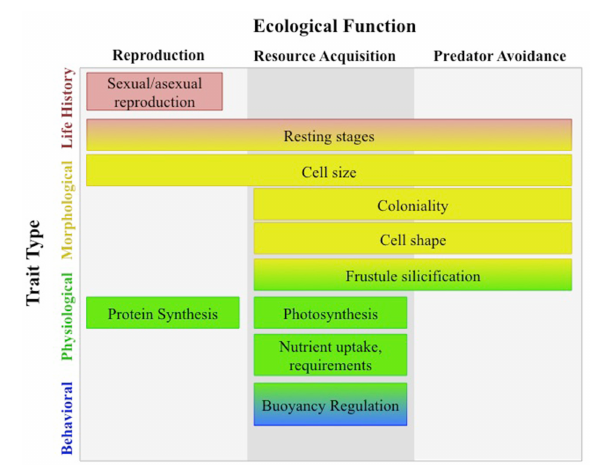
FIGURE 1 | Typology of diatom functional traits redrawn from Litchman and Klausmeier (2008). Trade-offs between many functional traits have significant implications for the functional ecology of marine systems as many of these traits are involved in resource acquisition and have direct control over biogeochemical fluxes. Physiological traits such as nutrient uptake directly affect the elemental cycles of carbon, nitrogen, phosphorus, and silicon; whereas, morphological traits such as cell size and frustule silicification regulate these biogeochemical cycles by effecting cell aggregation and cell sinking